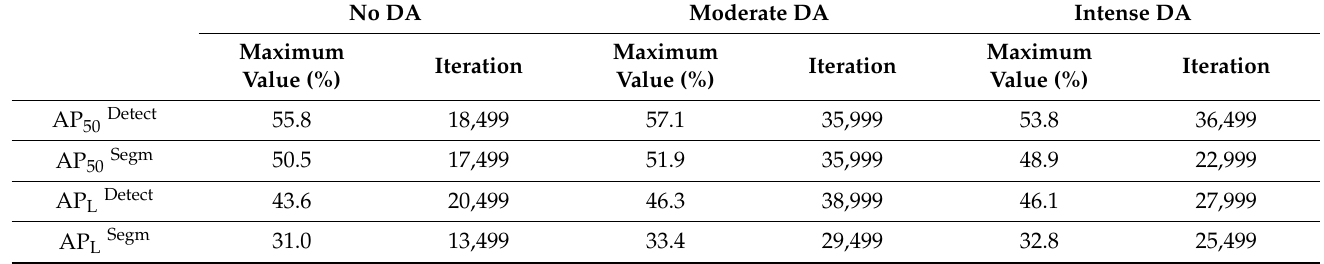
Table 5. Metrics values for models without DA, moderate DA, and intense DA.